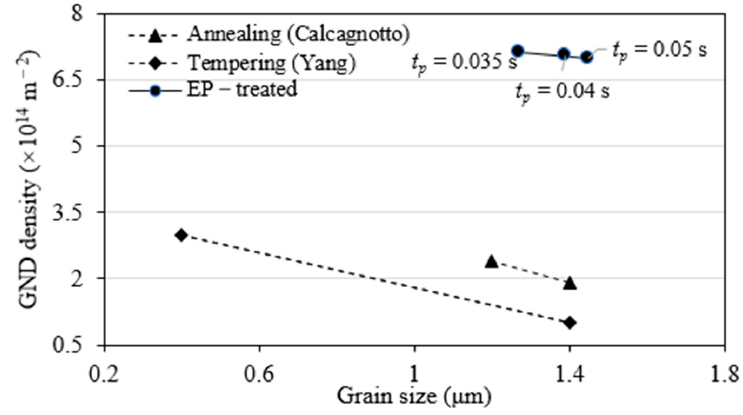
Figure 16. GND evolution under EPT.